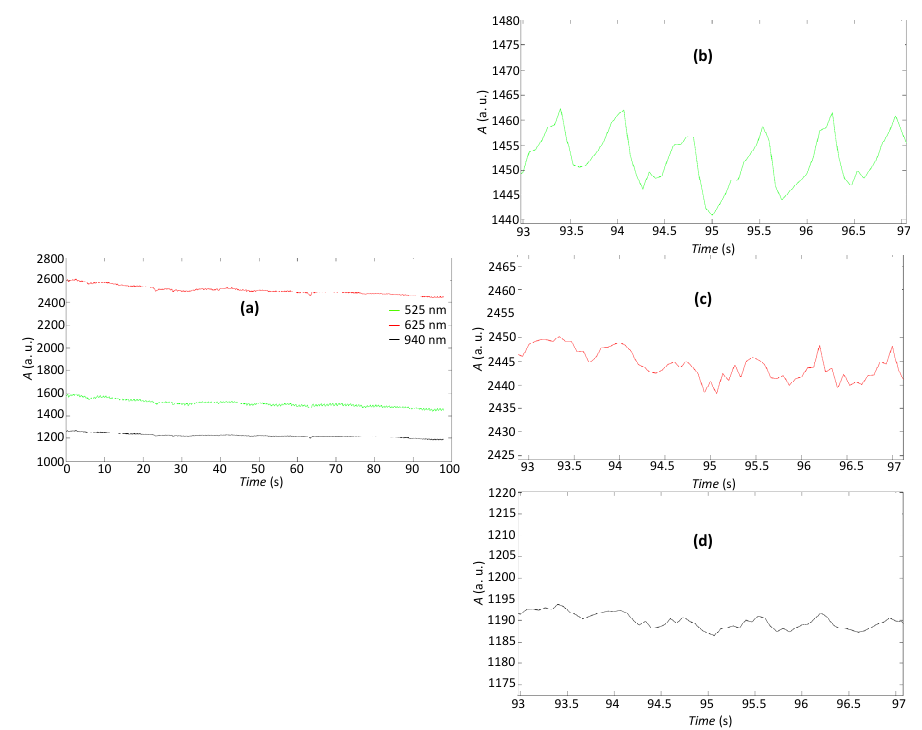
Figure 17. Measured PPGI data: ( a ) measured waveforms at three wavelengths, device set in sequential pulse mode; ( b ) a five-second detail of 525 nm waveform; ( c ) a five-second detail of 625 nm waveform; ( d ) a five-second detail of 940 nm waveform.